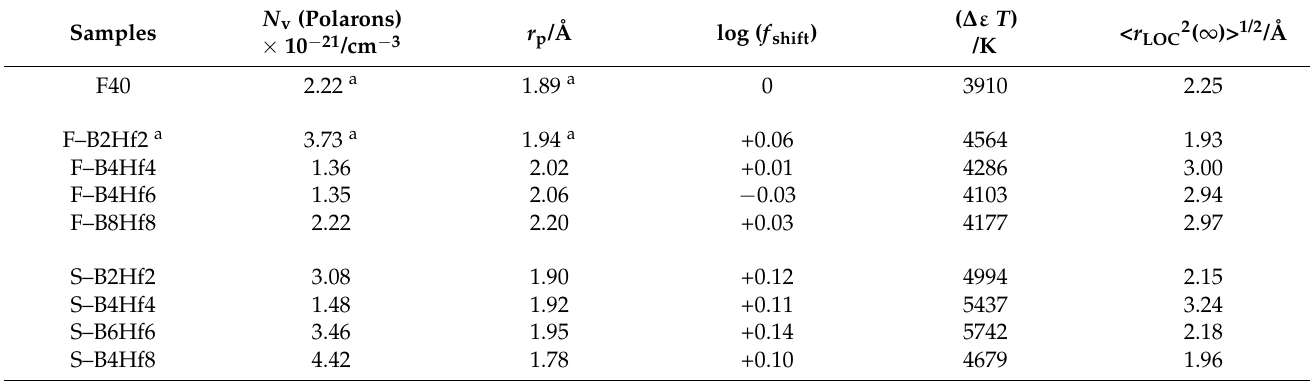
Table 3. Summary of parameters obtained from a detailed analysis of conductivity and permittivity spectra for all studied iron phosphate-based glasses containing B 2 O 3 and HfO 2